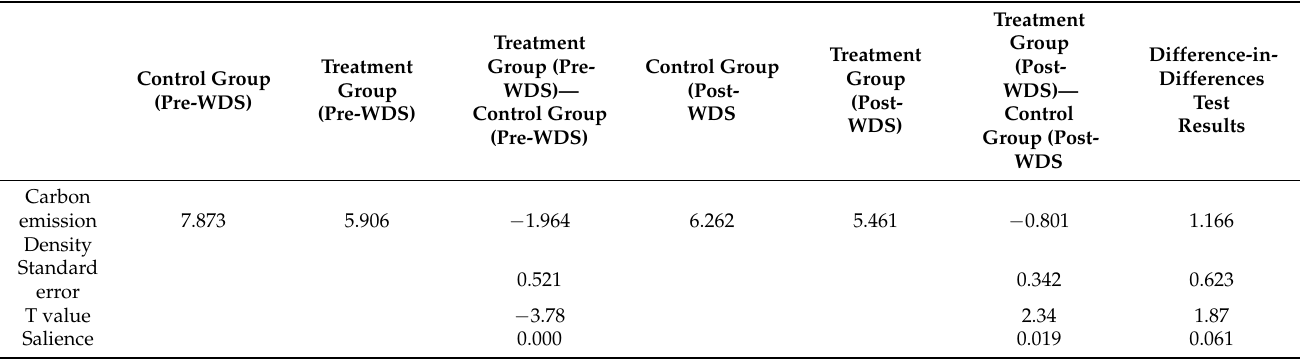
Table 4. PSM-DID test